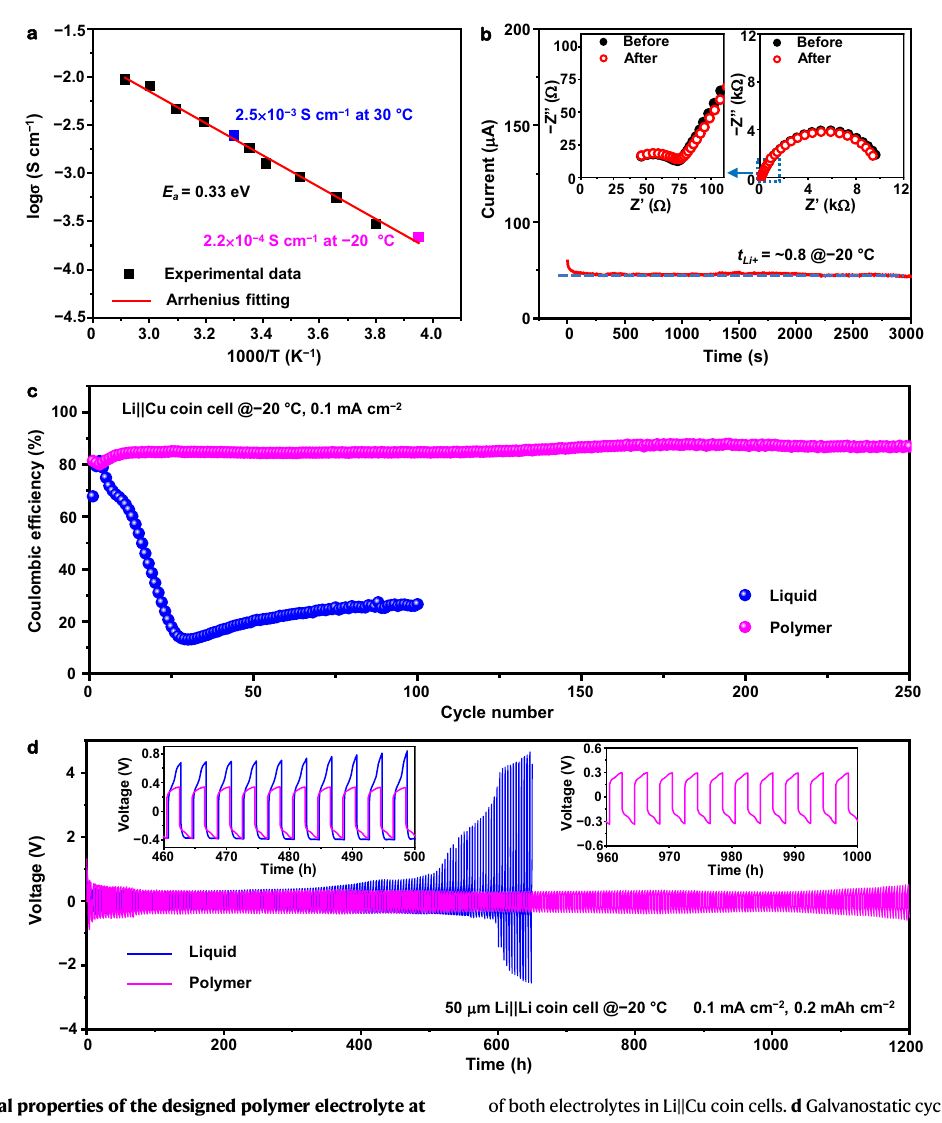
of both electrolytes inLi||Cu coin cells. d Galvanostaticcycling of both electrolytes in symmetric Li||Li coin cells, insets: the magni fi cation of voltage pro fi les during 460 – 500h and 960 –